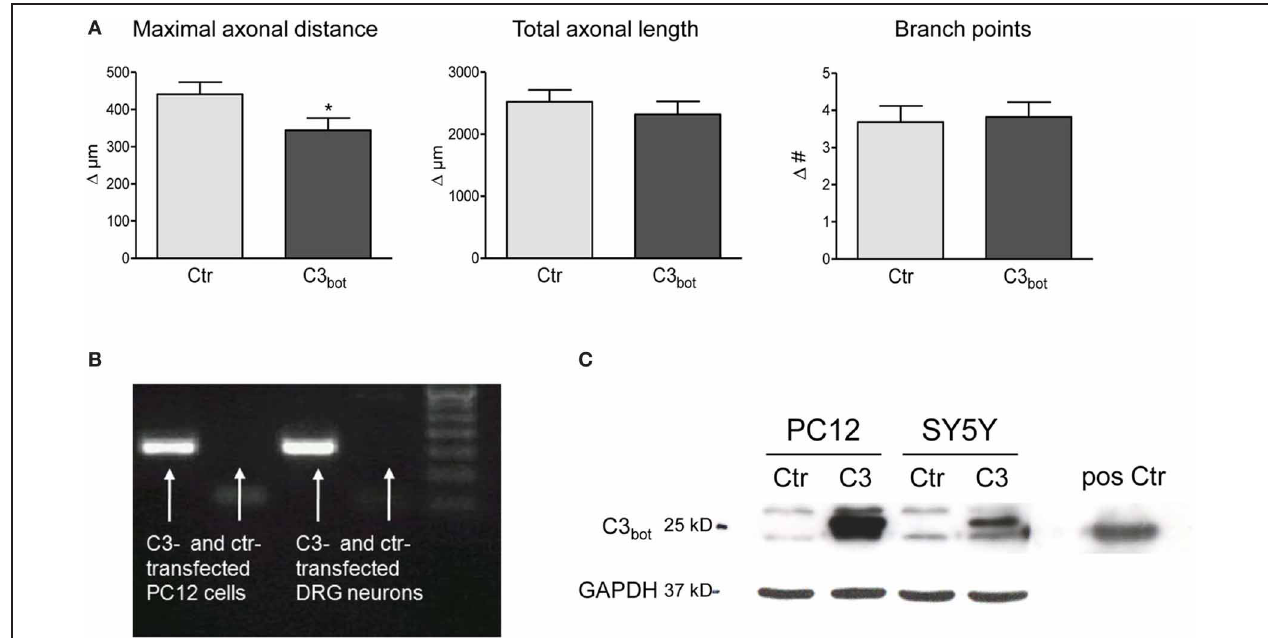
FIGURE 3 | Neuronal transfection of a plasmid encoding for C3 (pEGF-C3) and a marker plasmid encoding DsRed does not stimulate axonal growth (A) . Axon growth between day 2 and day 3 (results presented as delta) after transfection is followed cell-by-cell. The maximal axonal distance of C3 overexpressing neurons decreases compared to control DsRed-transfected neurons. No alterations in the total axonal length and the number of branch